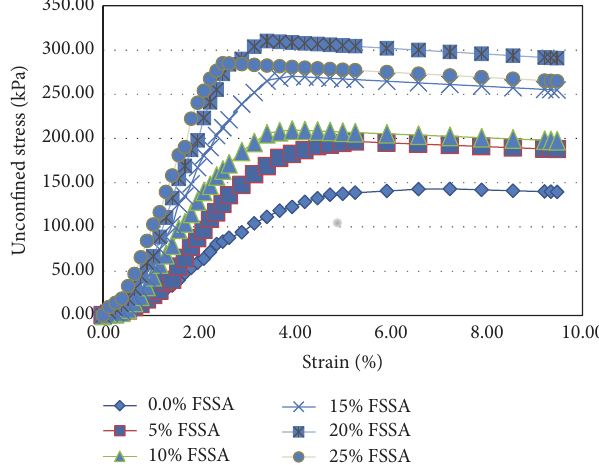
Figure 6: Stress shear strength versus strain for samples with different FSSA